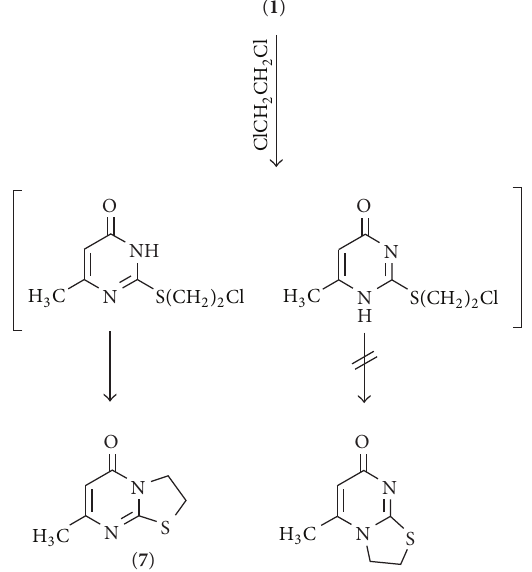
Scheme 4: Synthesis of 7-methyl-2,3-dihydro-5H-thiazolo[3,2-